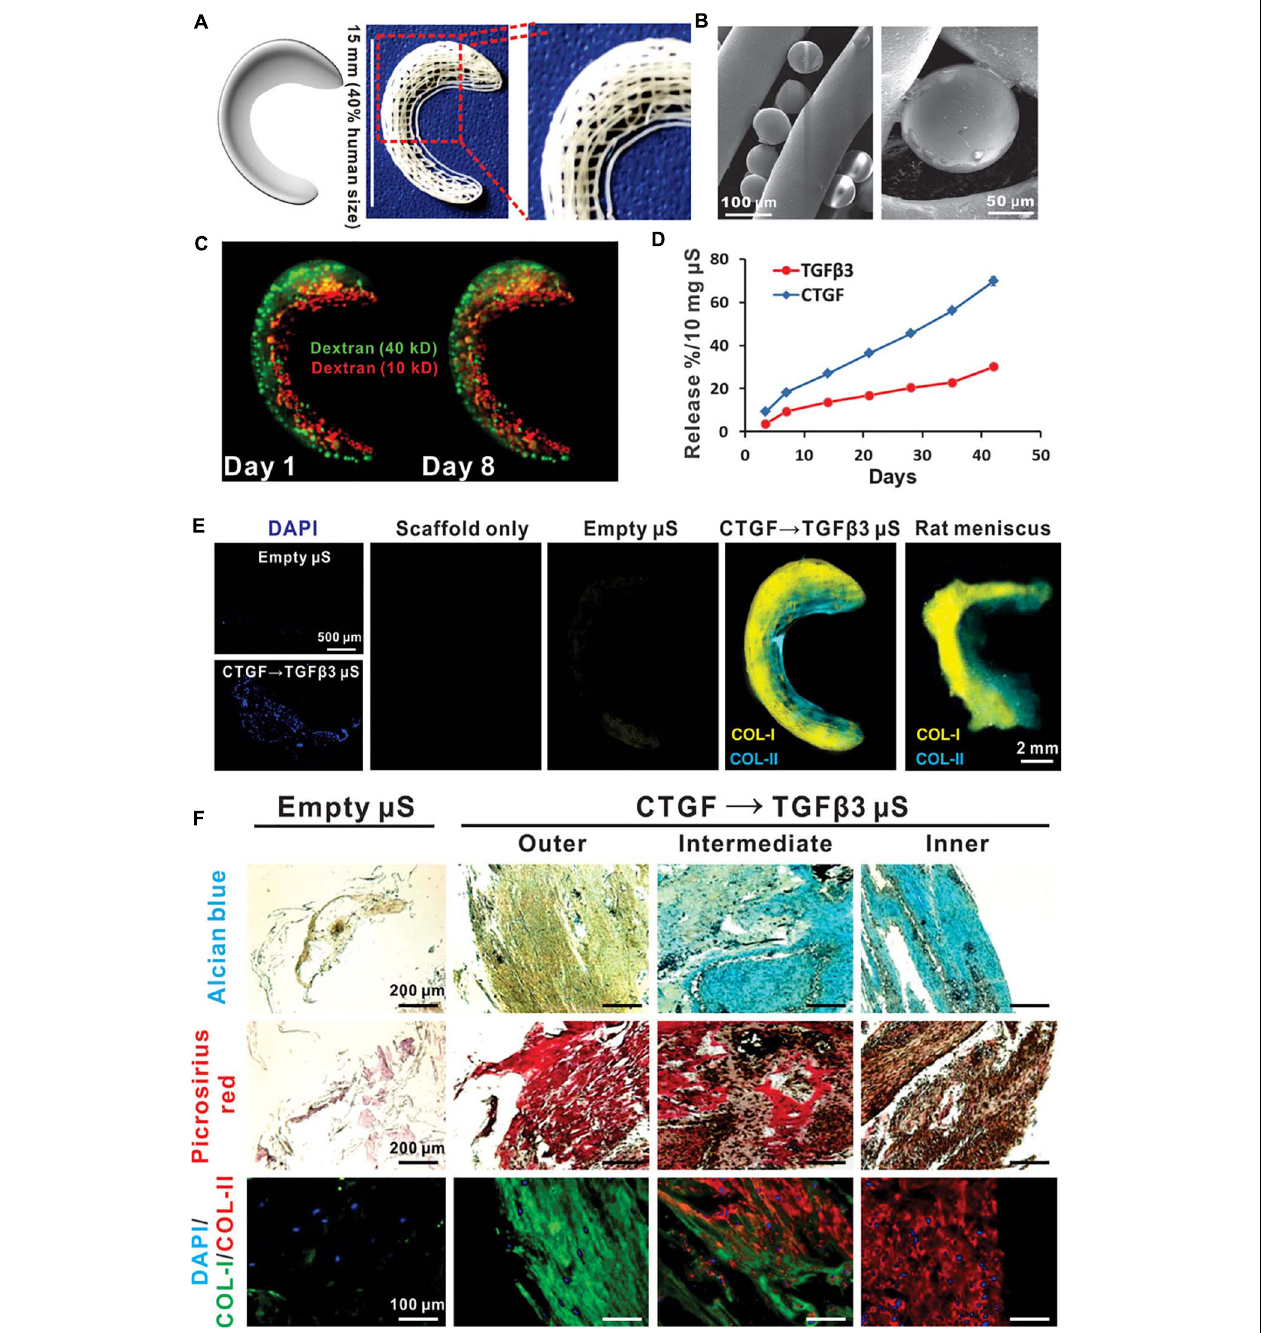
FIGURE 3 | Spatiotemporally released rhCTGF and rhTGF- β 3 induced fibrocartilage-like matrix formation in 3D-printed, porous scaffolds. (A) Anatomical reconstruction of human meniscus. Human meniscal scaffolds were 3D printed with the layer-by-layer deposition of PCL fibers (100 mm in diameter), forming 100- to 200-mm channels. (B) PLGA microspheres ( µ S) encapsulating rhCTGF and rhTGF- β 3 were in physical contact with PCL microfibers. (C) Fluorescent dextran simulating CTGF (green, 40 kD) and TGF- β 3 (red, 10 kD) was delivered into the outer and inner zones, respectively, of human meniscal scaffolds to show scaffold loading. The distribution of dextran was maintained from day 1 to day 8. (D) rhCTGF and rhTGF- β 3 release from the PCL scaffolds over time in vitro . (E) When the scaffolds were incubated atop human synovial MSC monolayers for 6 weeks, spatiotemporally delivered rhCTGF- and rhTGF- β 3 induced cells to form zone-specific collagen type I and II matrices, similar to those in the native rat meniscus. (F) Scaffolds with empty mS showed little matrix formation after 6 weeks of coculture with a 1:1 mixture of fibrogenic and chondrogenic supplements (no growth factors in medium). Spatiotemporal delivery of rhCTGF and rhTGF- β 3 induced fibrocartilaginous matrix formation, consisting of alcian blue-positive, collagen II-rich cartilaginous matrix in the inner zone and picrosirius red-positive, collagen I-rich fibrous matrix in the outer zone. A total of five replicates were tested, with representative images selected from the same scaffold (reprinted from Lee et al., 2014 with permission from